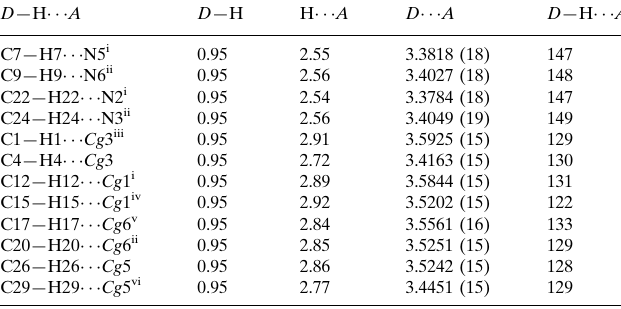
Hydrogen-bond geometry (A˚ , (cid:1)